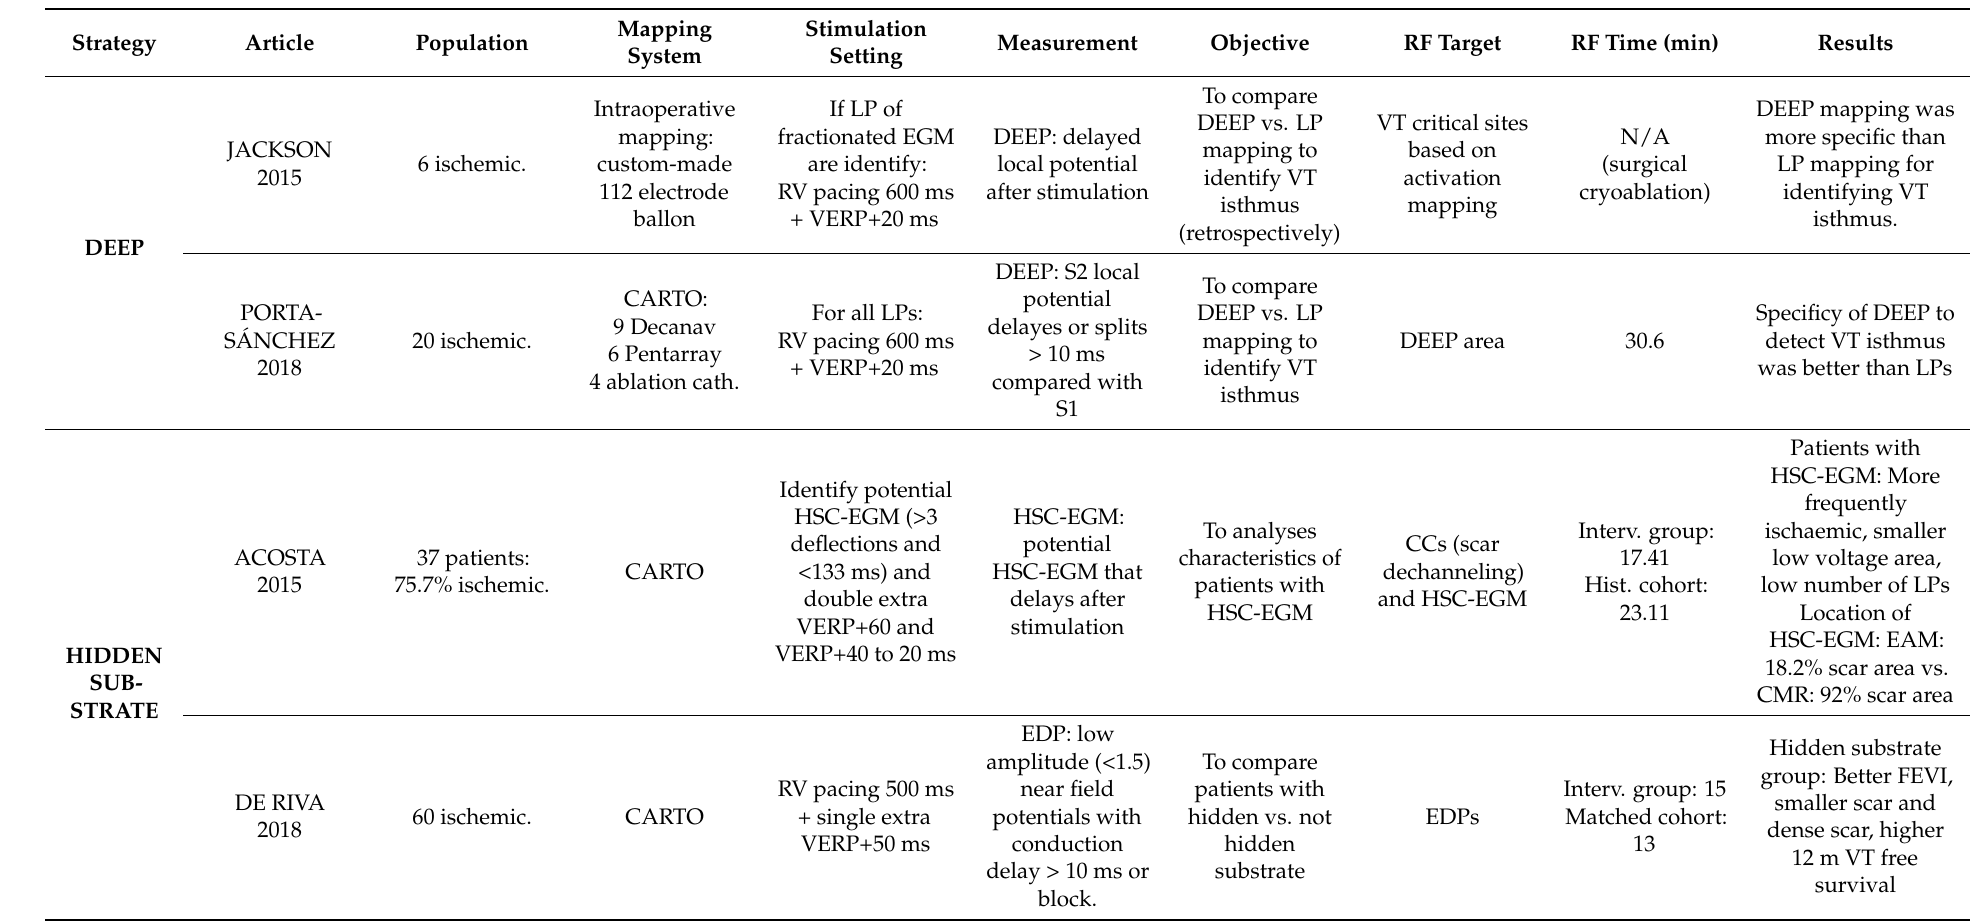
Table 1. Comparation of different VT functional mapping